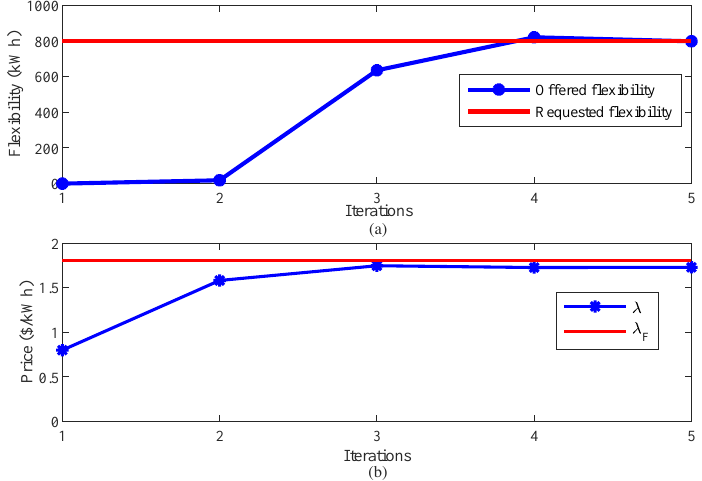
Figure 10. Distributed optimization approach: ( a ) evolution of flexibility ( b ) evolution of market